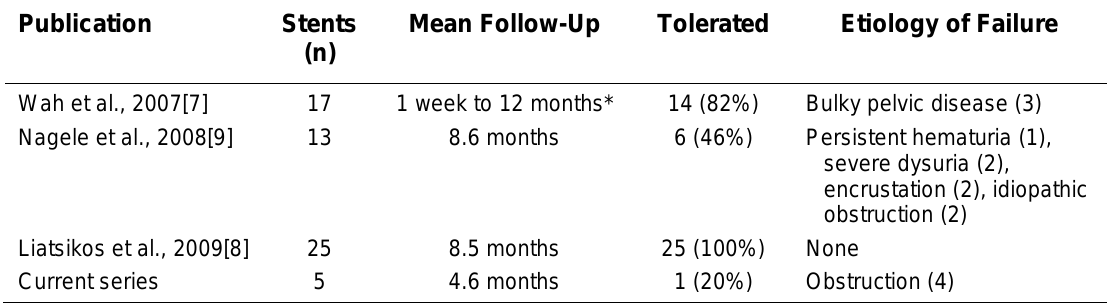
Reported Results of Stents in Treatment of Malignant Extrinsic Ureteral